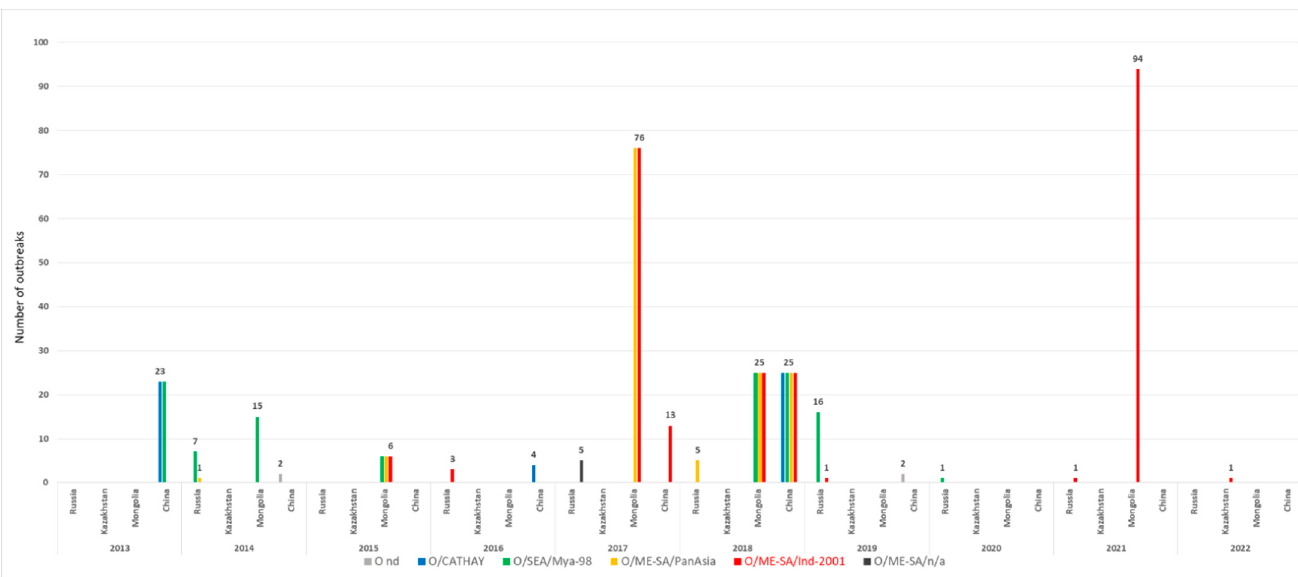
Figure 3. Time course of Type O foot-and-mouth disease outbreaks in Russia, Kazakhstan, and Mon- golia from 2013 to 2022 (dated 1 April 2022). Mongolia from 2013 to 2022 (dated 1 April 2022).